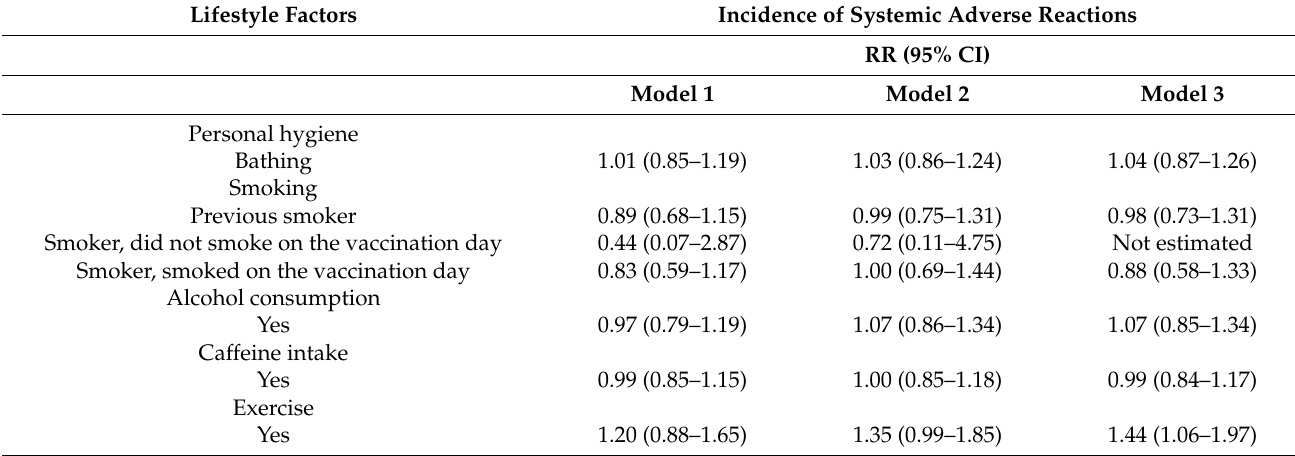
Table 5. Effect of lifestyle factors on systemic adverse reaction